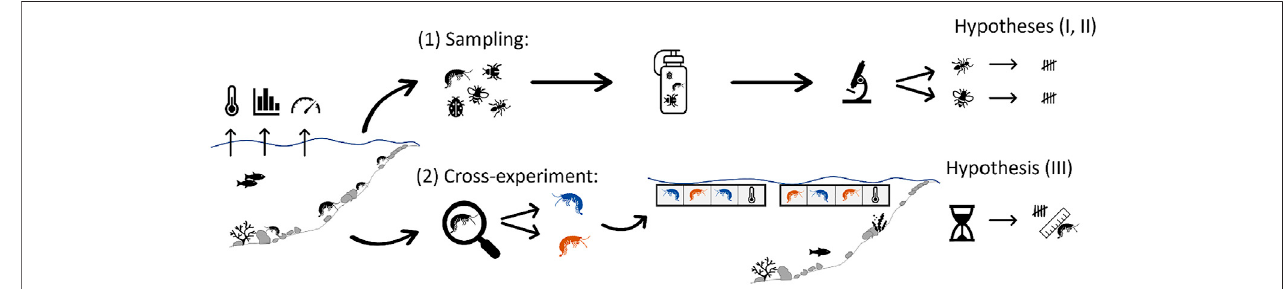
FIGURE 1 | Schematic view of the study concept including the dual experiments related to (A) the sampling of macroinvertebrates, and (B) cross-exposure of selectedMIV,andthehypothesestheyeachaddressed.Coloredpictogramsofgammarids(orange= Dikerogammarusvillosus andblue= Gammarusroeselii )represent the species used in the cross-exposure